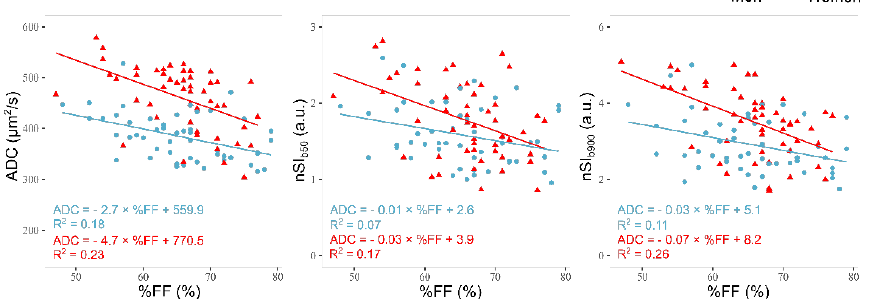
Figure A1. Scatterplots showing the correlation of apparent diffusion coefficient (ADC, left), muscle-normalized signal intensity of b50 and b900 images (nSI b50 , middle, and nSI b900 , right) and the fat fraction values (%FF). Linear regression lines and equations are reported.